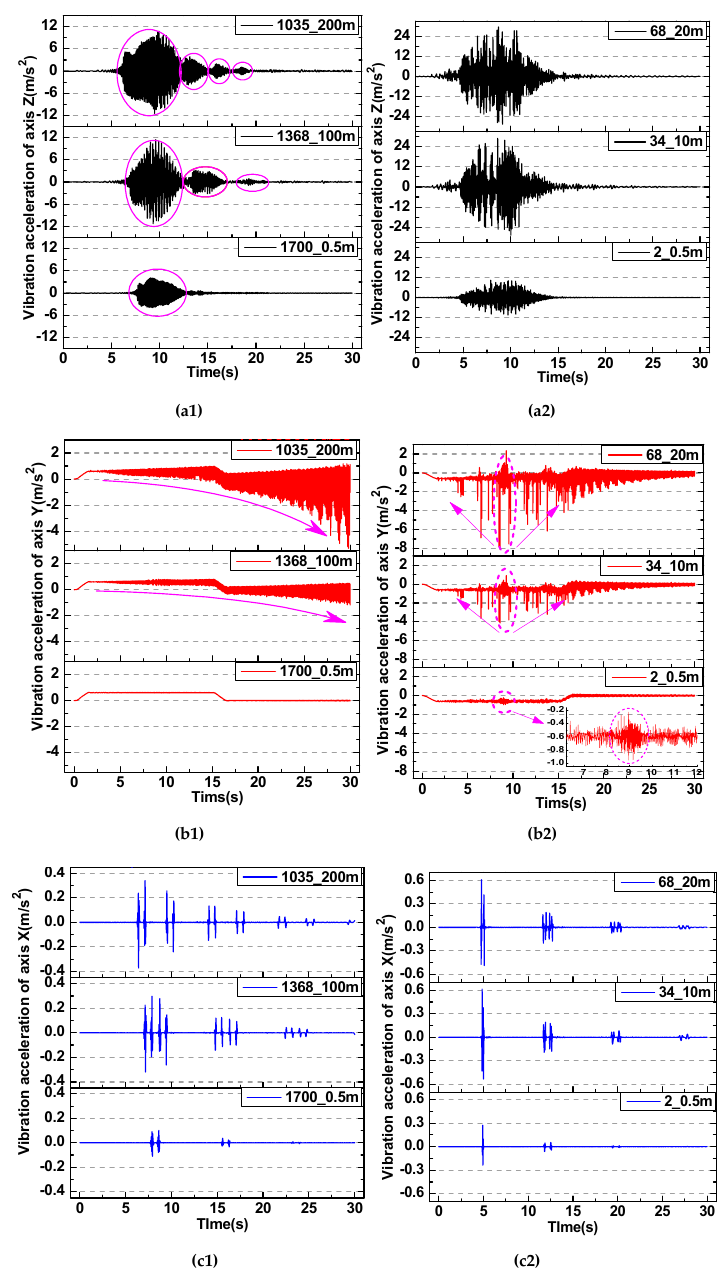
Figure 17. Rope vibration in three directions at different positions above the cage and the hammer. ( a1 ) Z-axis—above the cage, ( a2 ) Z-axis—above the hammer; ( b1 ) Y axis—above of the cage, ( b2 ) Y axis—above the hammer; ( c1 ) X-axis—above the cage, ( c2 ) X-axis—above the hammer.